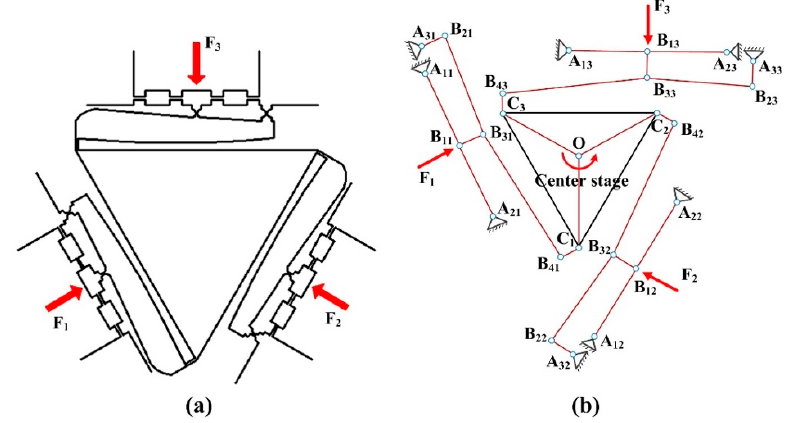
Figure 1. ( a ) Major part and ( b ) pseudo-rigid-body model of the vibration-assisted polishing device (VPD).